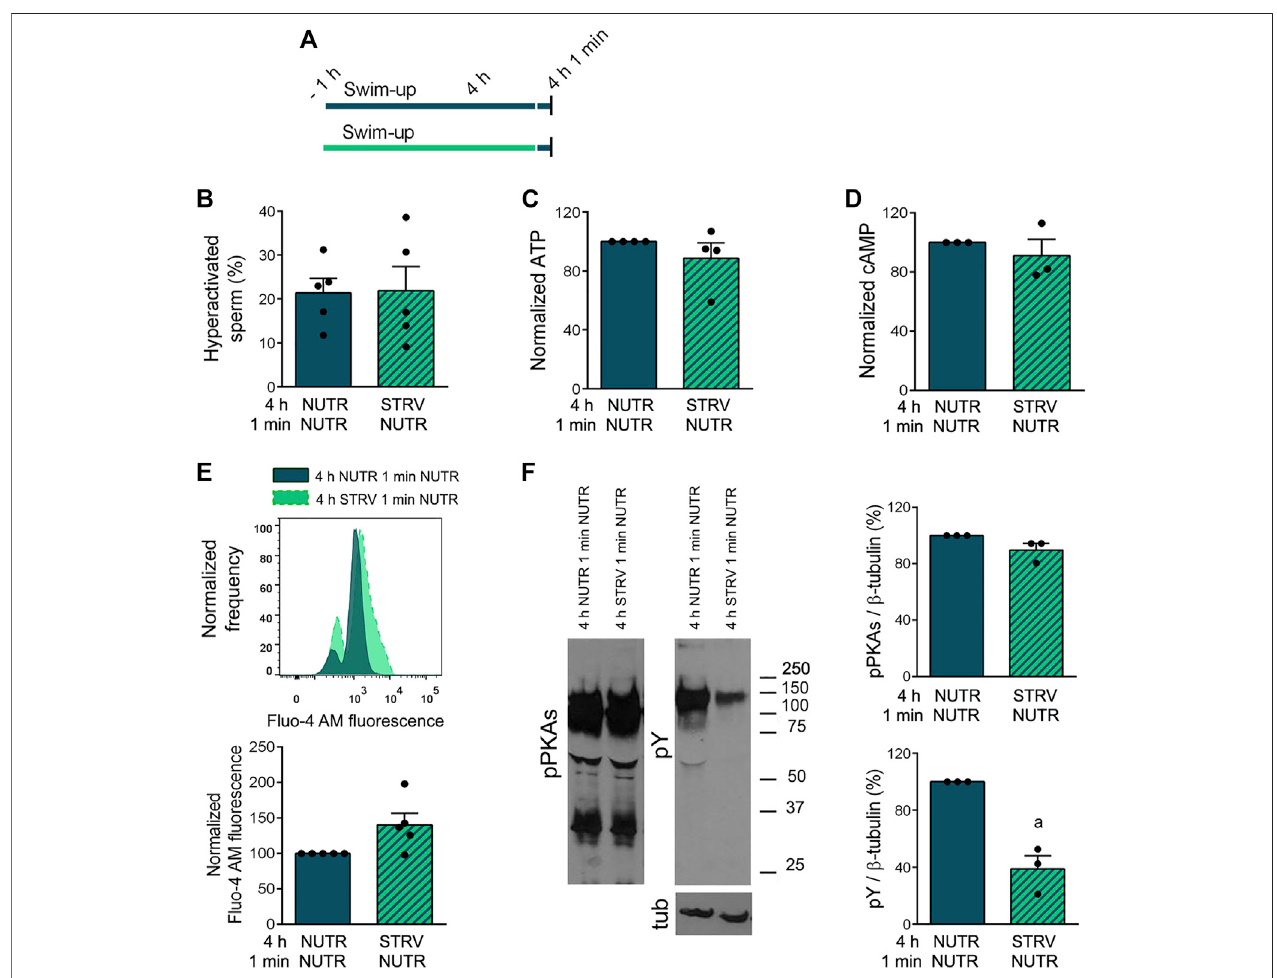
FIGURE6| Capacitation-relatedeventsinspermincubatedinstarvingconditionandsubjectedtorecoveryinNUTRmediumfor1 min. (A) Experimentaldesign.Motile humanspermwereselectedbyswim-upandincubatedfor4 hincapacitatingconditionsinNUTRorSTRV,andthenexposedtoNUTRmediumfor1 min. (B) Hyperactivated sperm. (C) ATP levels normalized against 4 h NUTR 1 min NUTR condition. (D) cAMP levels normalized against 4 h NUTR 1 min NUTR condition. (E) [Ca 2+ ] i levels. Top: Representativehistogramsofnormalizedfrequencyvs.Fluo-4AM fl uorescenceofnon-PIstained sperm(live)areshown. Bottom:NormalizedFluo-4AM fl uorescence compared to 4 h NUTR 1 min NUTR condition. (F) pPKAs and pY levels. Left: Representative Western immunoblotting results are shown. Right: Protein signals were quanti fi ed and expressed as relative to β -tubulin (Tub). Results are expressed as mean ± SEM, n ≥ 3 experiments. a p < 0.05 vs. 4 h NUTR 1 min NUTR. Student ’ s t test.